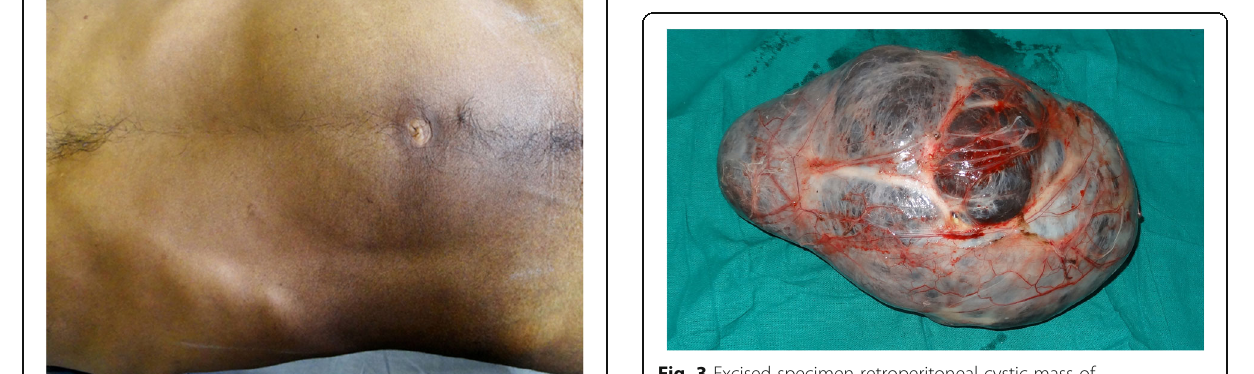
Fig. 3 Excised specimen retroperitoneal cystic mass